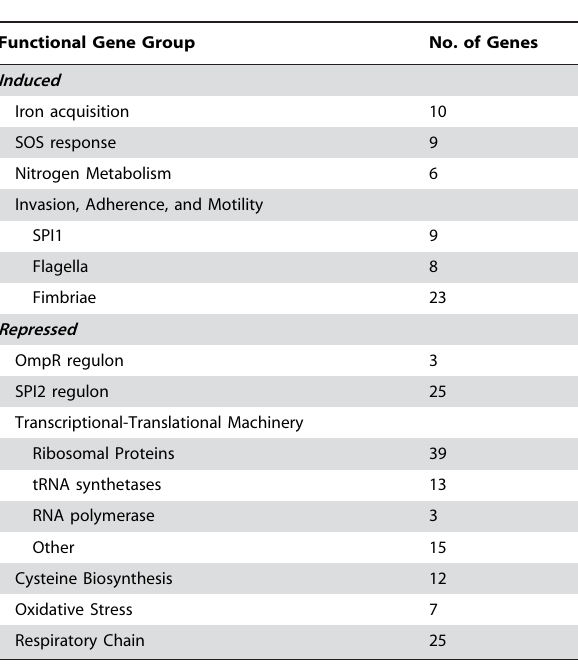
Table 2. Classification of NO-responsive genes in Salmonella cultured in EG medium pH